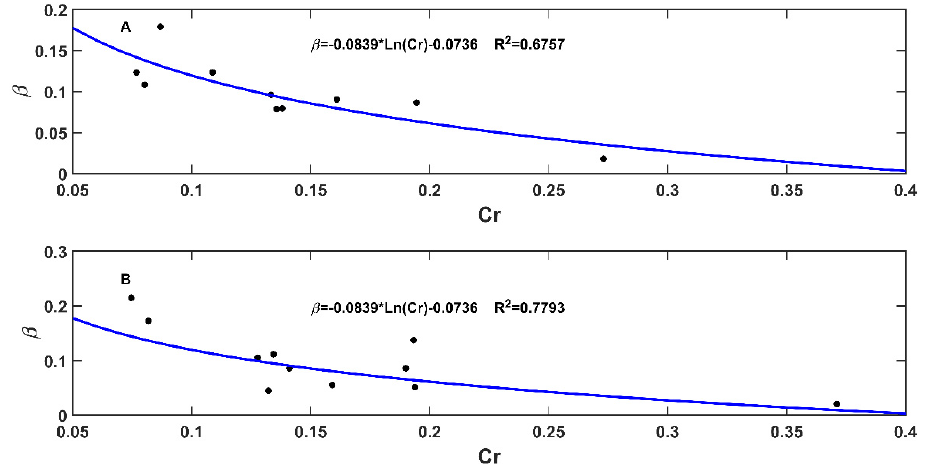
Figure 11. Relationship between the runoff coefficient and β parameter (calibration, the upper part of the panel; and validation, the lower part of the panel).